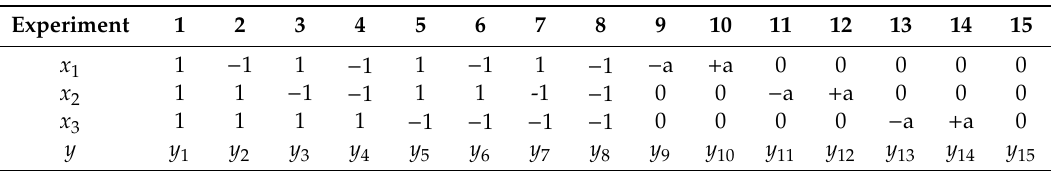
Table 1. An example of a variable input matrix.